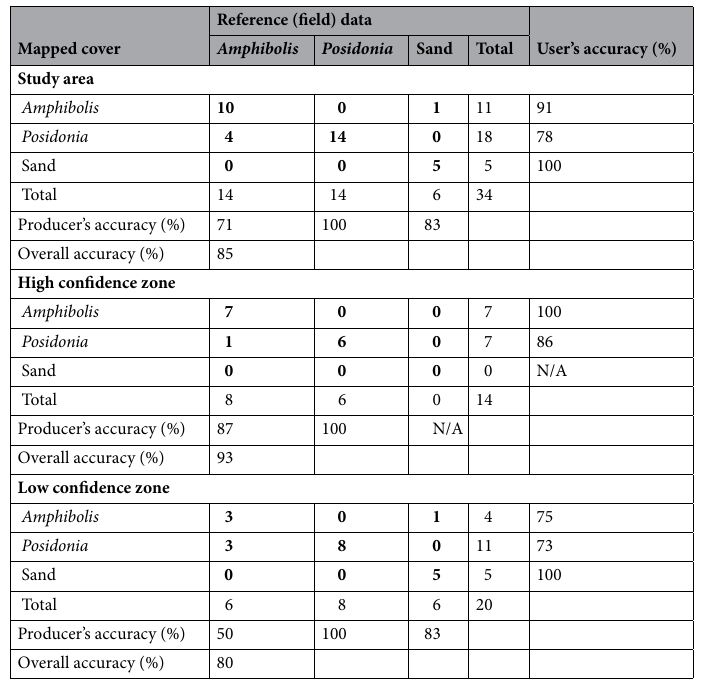
Table 2. Confusion matrix based on number of sites, and accuracy for the genus level